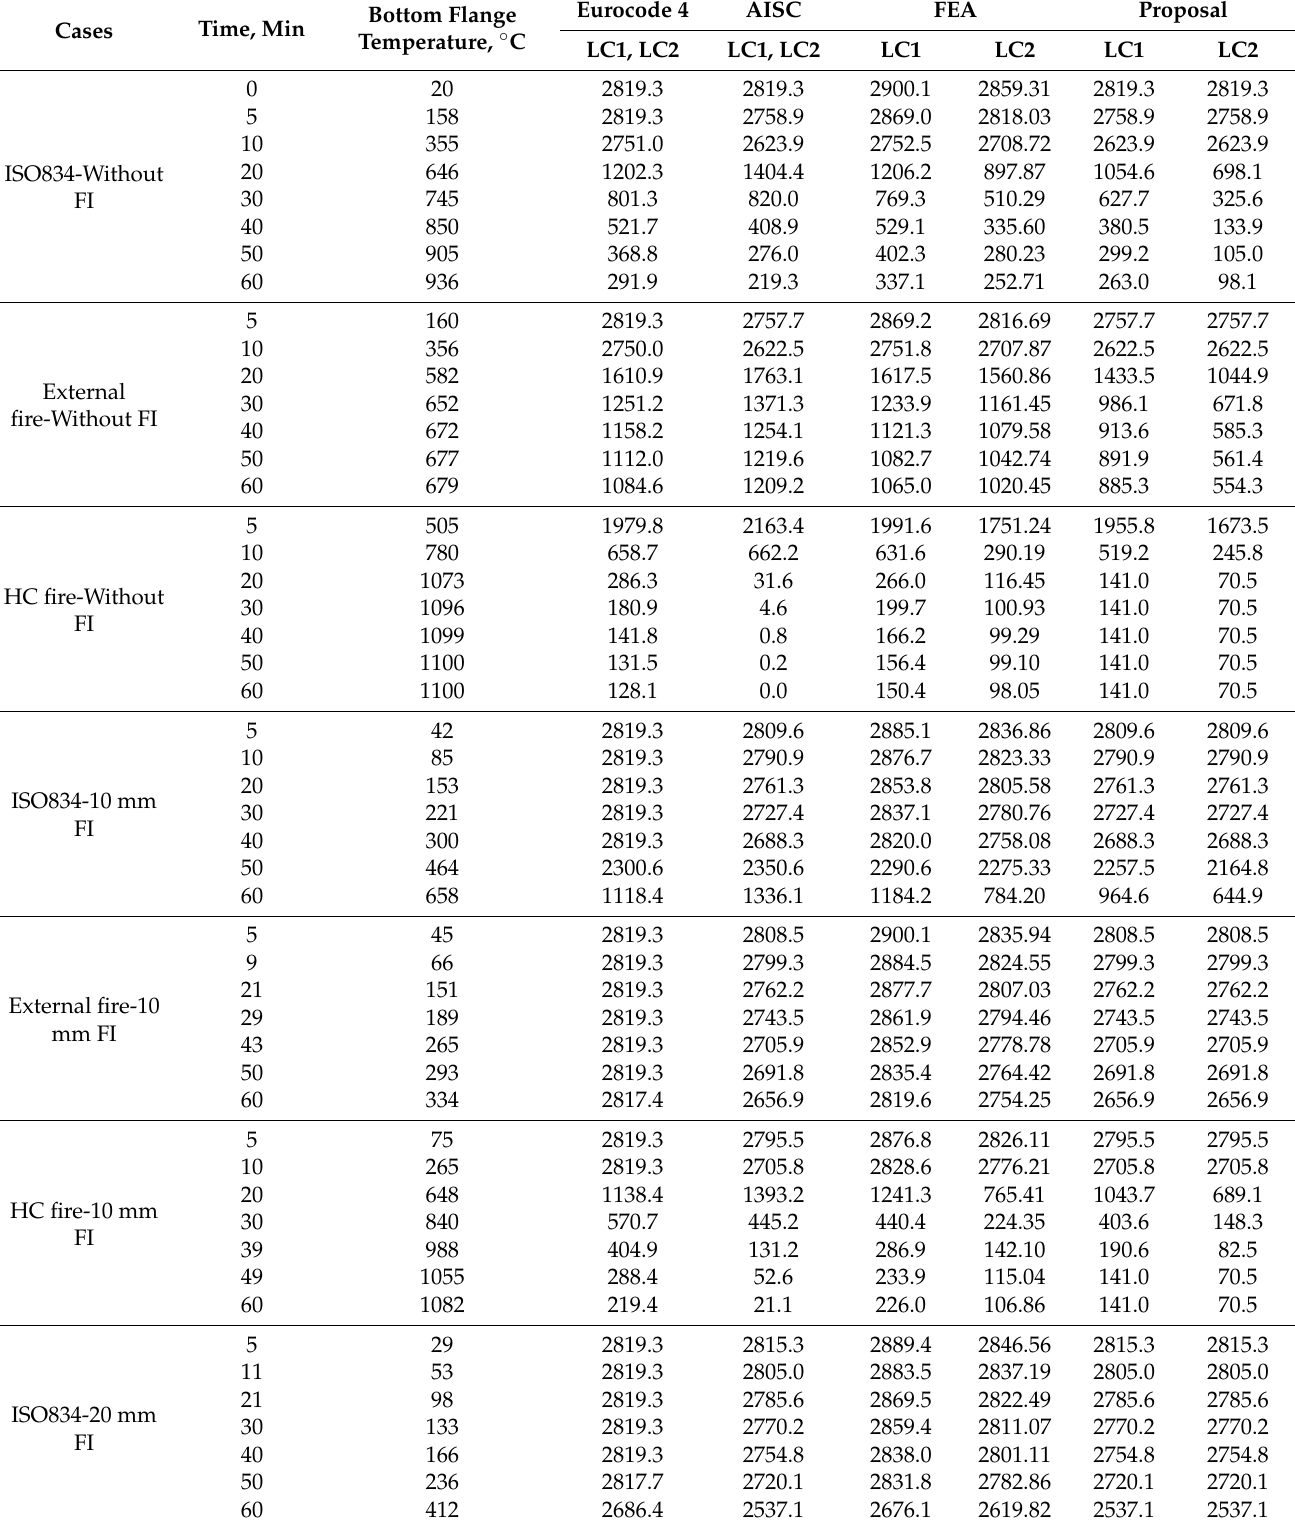
Table A1. Moment capacity obtained from Eurocode 4, ANSI/AISC, FEA and proposal; unit: kN ·